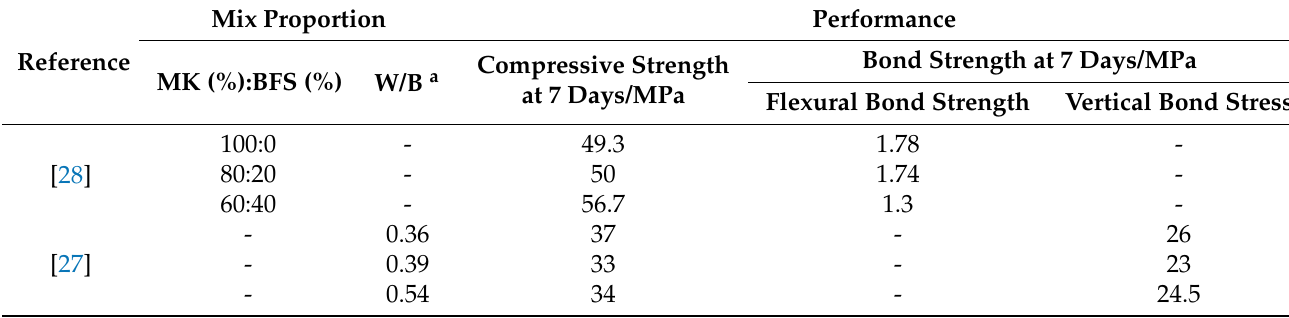
Table 7. Properties of Alkali-Active Materials mortar as repair materials.